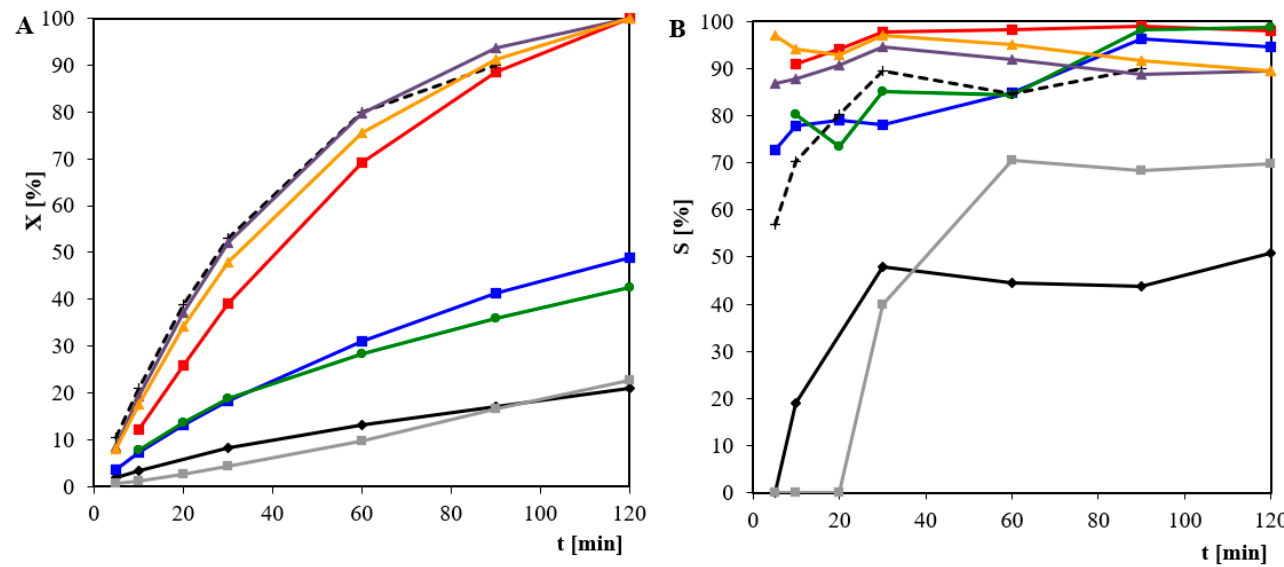
Figure 2. ( A ) Conversion degree of glucose X [%]; ( B ) selectivity to gluconate ions S GLC [%] of different catalysts: 5% Pd/SiO 2 ( ); 5% Au/SiO 2 ( ); 5% Pd-0.2% Au/SiO 2 ( ); 5% Pd-0.5% Au/SiO 2 ( ); 5% Pd-1% Au/SiO 2 ( ); 5% Pd-2% Au/SiO 2 ( ); 5% Pd-5% Au/SiO 2 ( • ), and 1% Pt-4% Pd-5% Bi/C (Degussa) ( × ) as a function of time. Reaction conditions: T = 60 ° C, m cat = 1g, C 0 = 1 mol·dm − 3 , pH = 9, V O 2 = 1 dm 3 ·min − 1 .